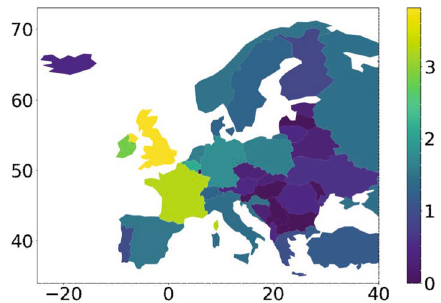
Fig. 4 Geographic distribution of the seed tweets in Europe. Colors show the base 10 logarithm of the tweet count